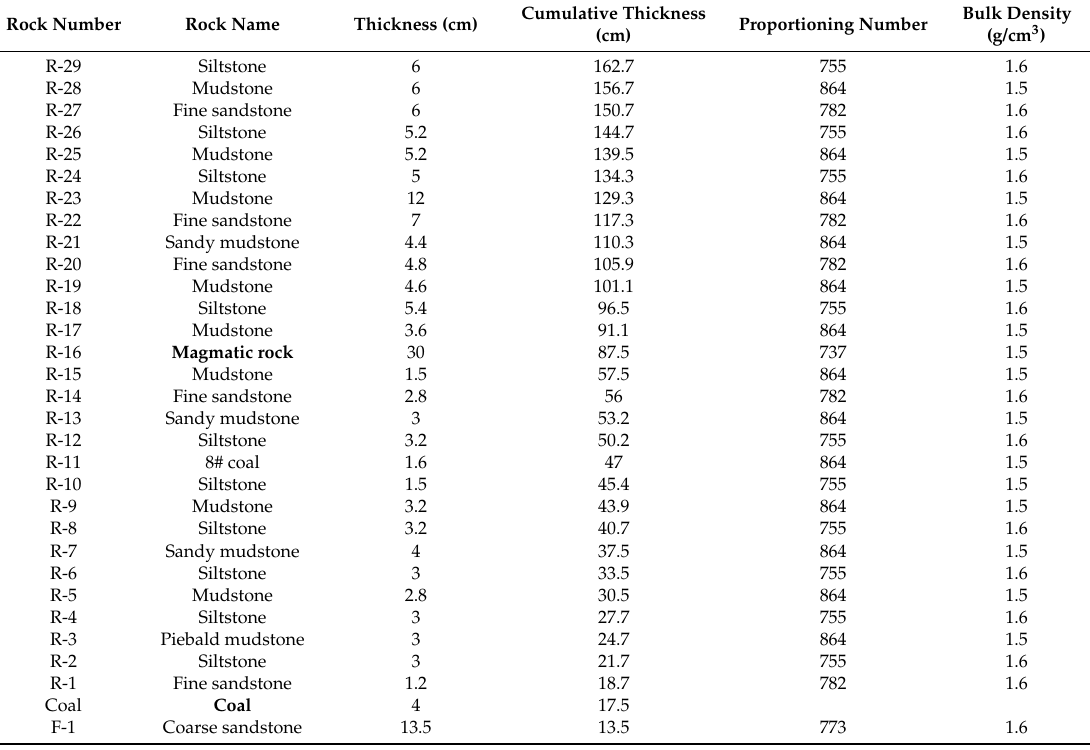
Table 3. Ratio of materials and materials for different strata in similar simulation